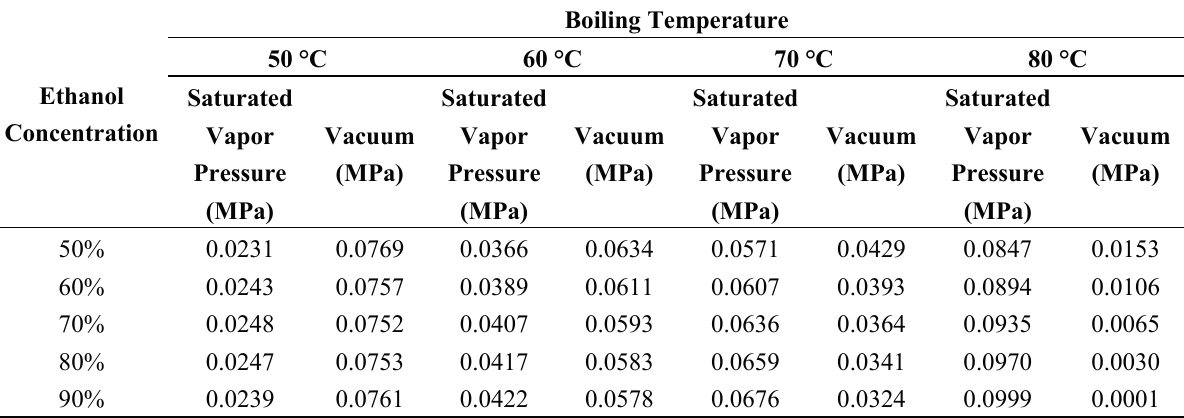
Table 1. Relationship among the vacuum, ethanol concentration and boiling temperature.